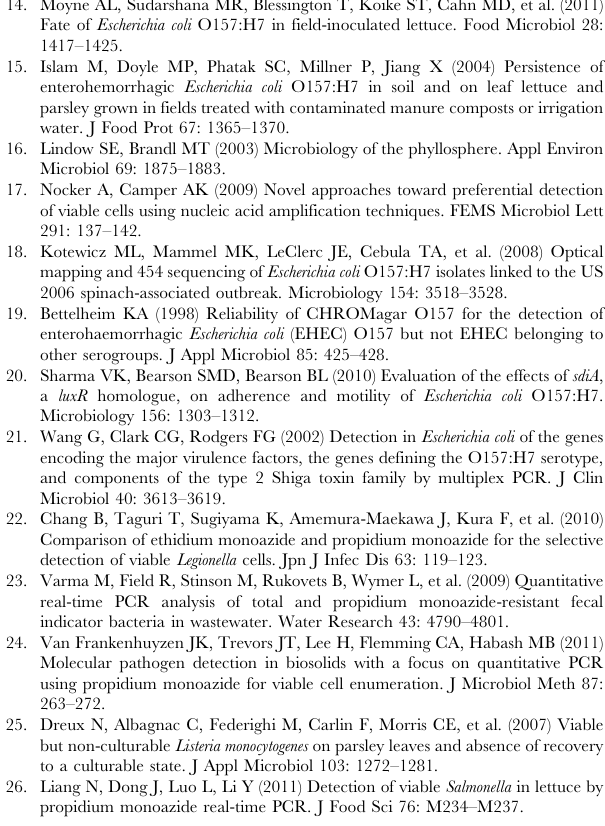
Table S1 Primers used in this study. Table S2 Ct values for real-time PCR measurements performed using different annealing temperatures